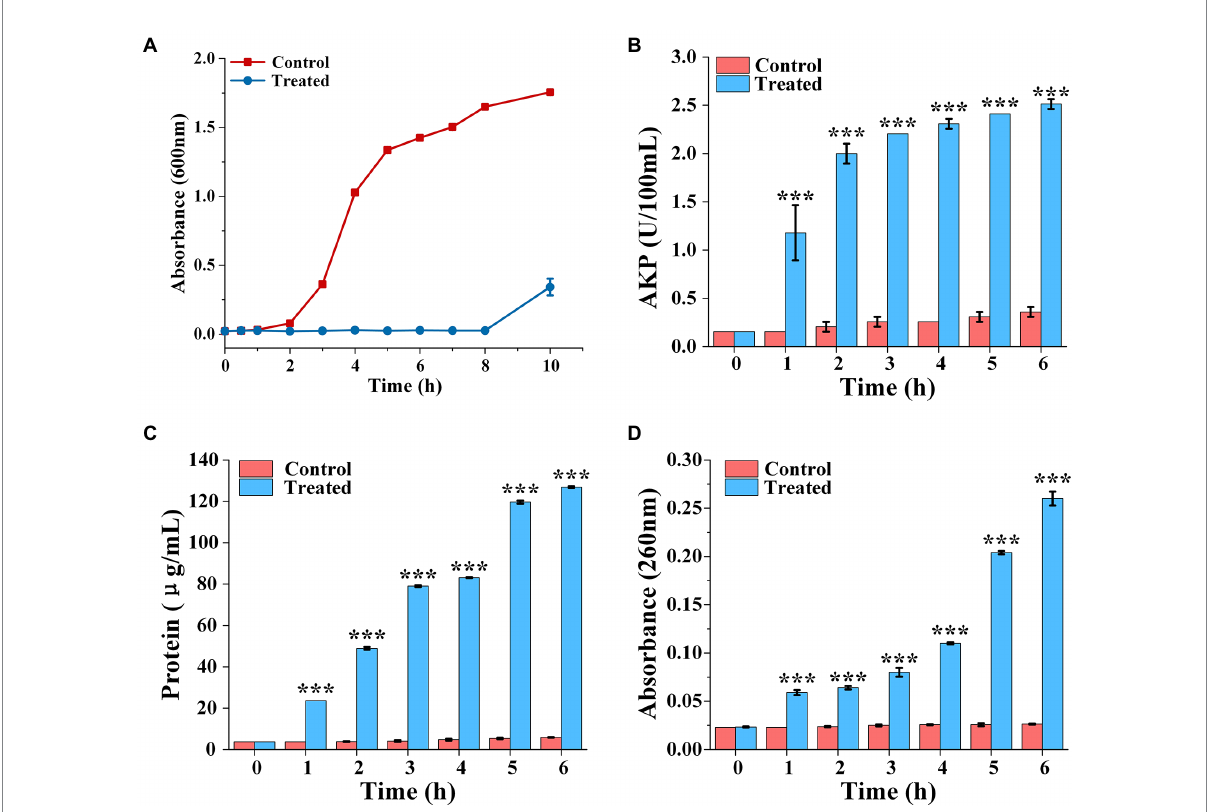
FIGURE 2 The growth curve of Staphylococcus aureus treated with FCS (A) . Determination of extracellular AKP content of S. aureus after FCS treatment (B) . The release of protein from S. aureus cells after FCS treatment (C) . The leakage of nucleic acids from S. aureus after FCS treatment (D) . *** (three asterisks) represents highly significant differences ( p < 0.001) in the comparison between the Control and the Treated.